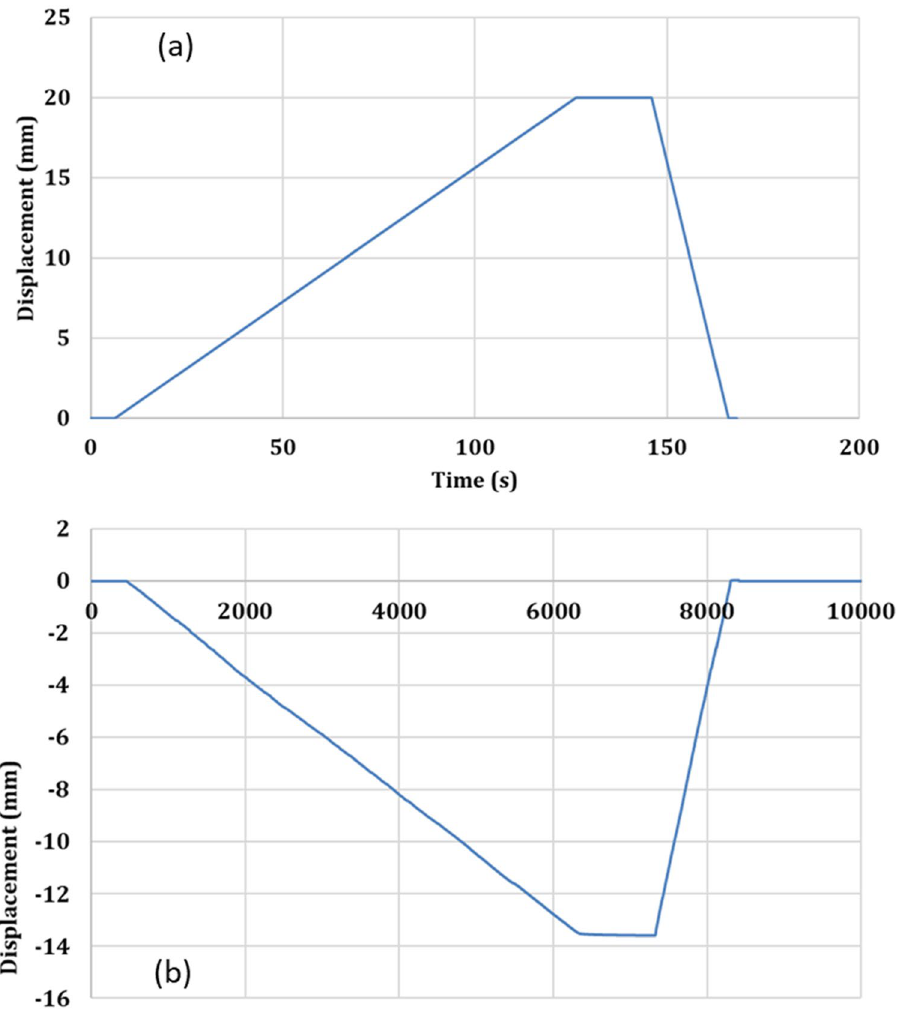
Figure 13. Longitudinal ( a ) and transverse ( b ) displacements recorded in the case of tensile test of auxetic structure.